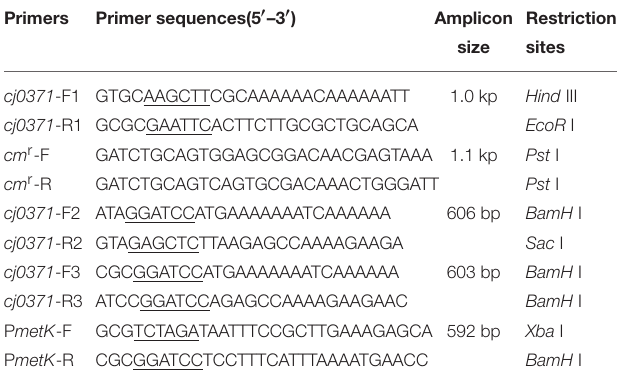
TABLE 2 | Primers used in this